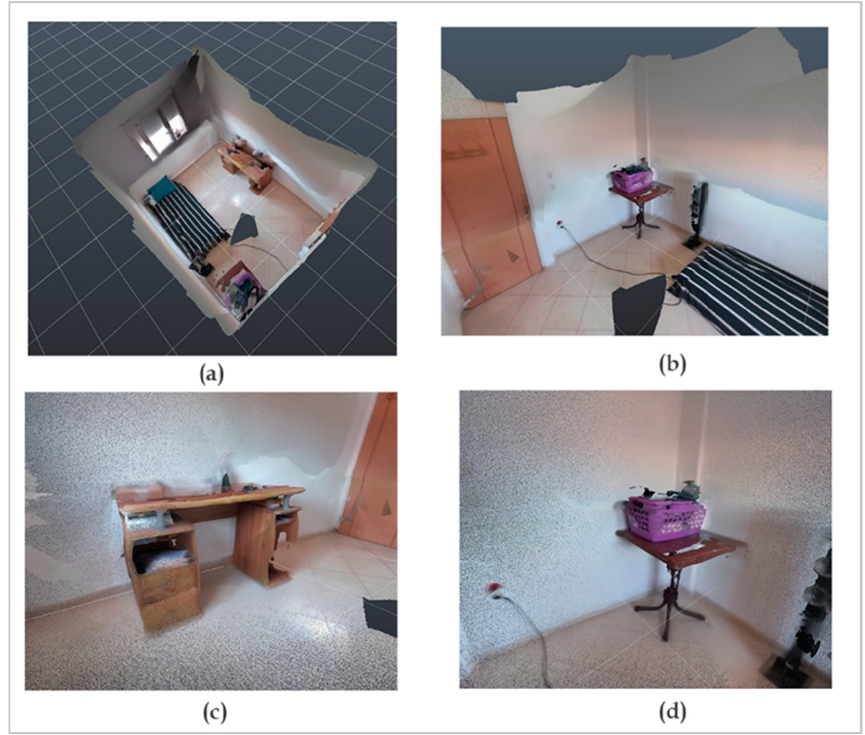
Figure 14. Result of the indoor 3D reconstruction of the room: ( a ) global view of the room from the top; ( b – d ) focus on corners and objects.